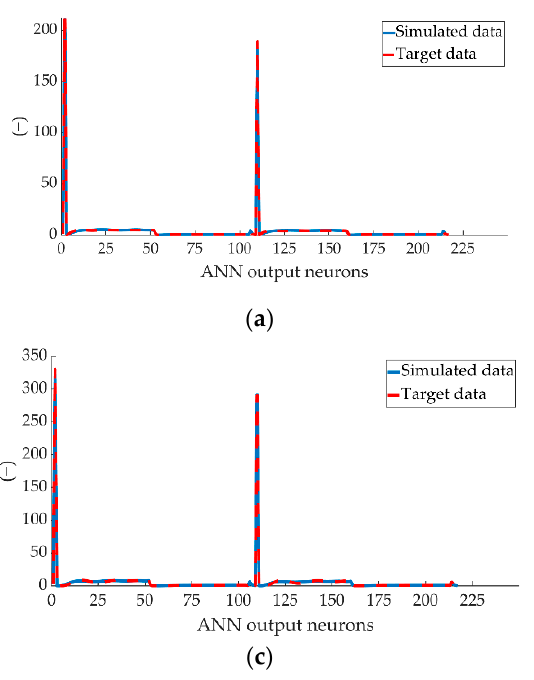
Figure 16. Comparison between the complete data simulated by ANN and the target data for braking at a speed of 70 km/h for type: ( a ) maintained, ( b ) progressive and ( c ) emergency.